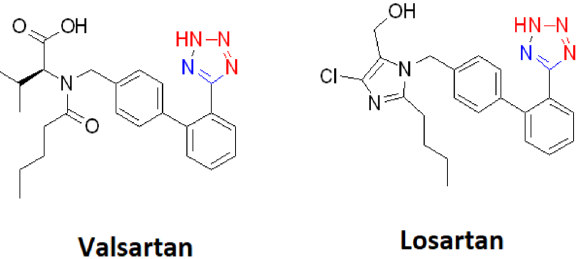
Figure 1. Valsartan and losartan as two active pharmaceutical ingredients with tetrazole